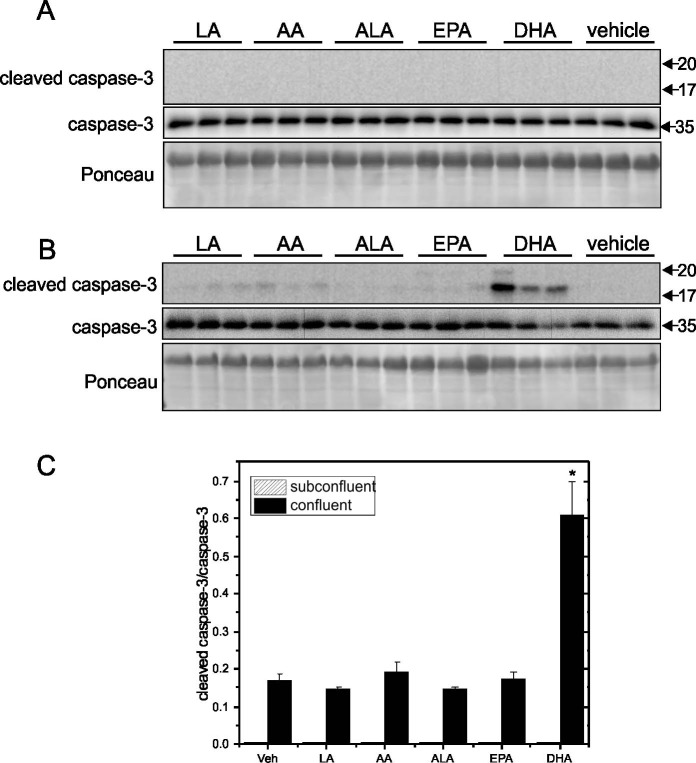
Effect of PUFA treatment on cleaved caspase-3 and caspase-3 in subconfluent and confluent EA.hy926 cells grown on Matrigel-coated plates.EA.hy926 endothelial cells were seeded on Matrigel-coated plates at 9000 cells/cm2 and grown for 4 days. Cells were treated with PUFAs (LA, AA, ALA, EPA and DHA) individually at 125 μM for 8 h. Protein levels of cleaved caspase-3 and caspase-3 were determined by Western blotting of cell lysates prepared after treatments. Representative blots are shown in Panel A (subconfluent) and Panel B (confluent). Densitometry was used to quantify the intensity of the bands in the upper panels. Data are presented as means ± SEM (n = 3) for cleaved caspase-3/caspase-3 (Panel C). *Significantly different (p <0.05) from vehicle control.